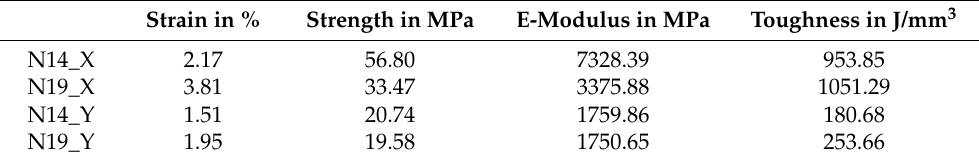
Table 2. Averaged values for strain at break, strength, stiffness and toughness of the specimens. Strain in % Strength in